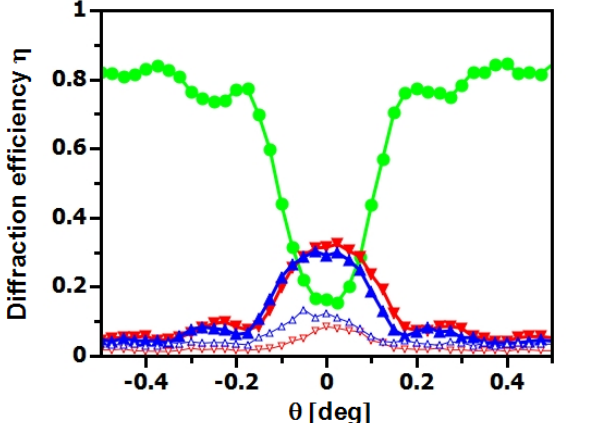
Figure 12. Rocking curve of an H-PDLC grating measured at λ ≈ 4 . 4 nm ( N · · · − 1 st order, l . . . 0 th order, H · · · + 1 st order, △ · · · − 2 nd order, ▽ · · · + 2 nd order). Grating = 30 µ parameters: Λ = 1 . 2 µ m, d 0